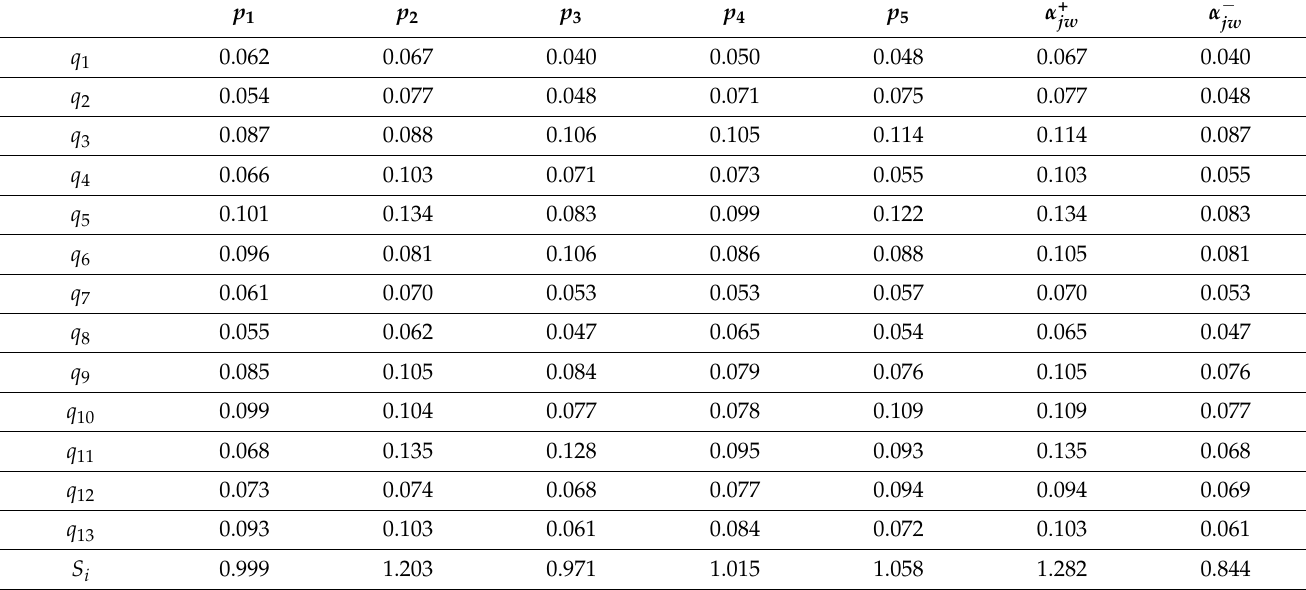
Table A7. Score values weighted normalized AIF-DM of each option for prioritizing the BESSs.